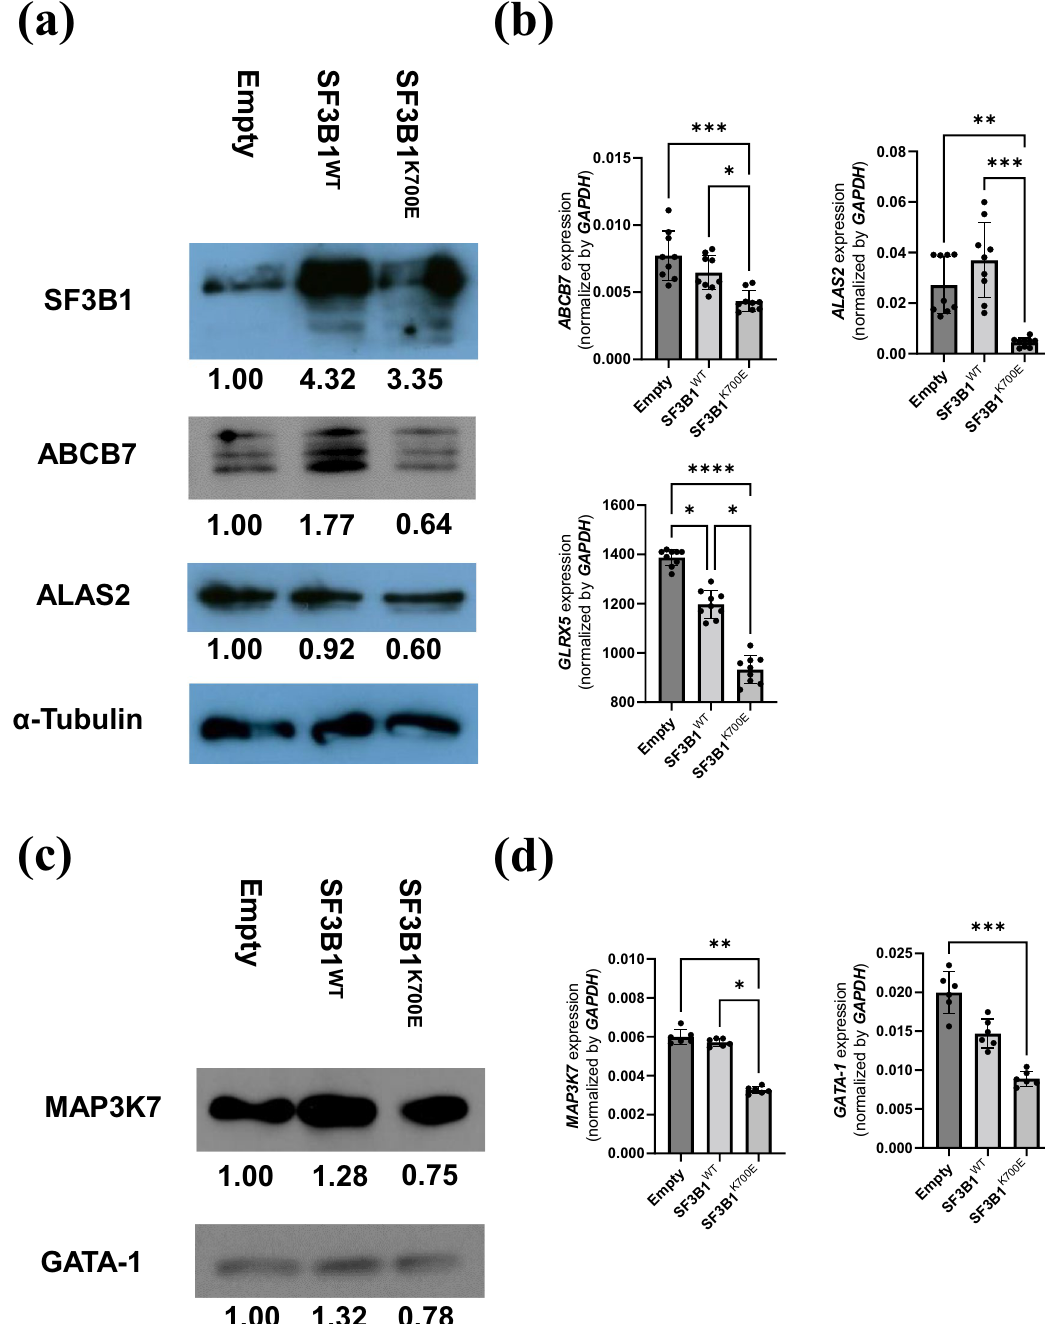
Figure 2. Gene expression analysis of HUDEP-2 cells stably expressing SF3B1 K700E . ( a ) Western blot analysis for SF3B1, ABCB7, and ALAS2. Relative expression level of each gene in HUDEP-2 cells stably expressing SF3B1 WT or SF3B1 K700E in comparison to control vector-transduced HUDEP-2 cells are described under each picture. α-Tubulin was used as a loading control. The image of each protein was cropped from the different films. The original films are presented in Supplementary Fig. S6–9 online. ( b ) Expression levels of ABCB7 , MAP3K7 and GLRX5 were measured by quantitative RT-PCR (results shown as mean ± SD and dot plots); * p < 0.05, ** p < 0.01, *** p < 0.001, **** p < 0.0001. ( c ) Western blot analysis for MAP3K7 and GATA-1. Relative expression level of each gene in HUDEP-2 cells stably expressing SF3B1 WT or SF3B1 K700E in comparison to control vector- transduced HUDEP-2 cells is described under each picture. α-Tubulin was used as a loading control ( a ). The image of each protein was cropped from the different films. The original films are presented in Supplementary Fig. S10–11 online. ( d ) Expression levels of MAP3K7 and GATA-1 were measured by quantitative RT-PCR (results shown as mean ± SD and dot plots); * p < 0.05, ** p < 0.01, *** p <